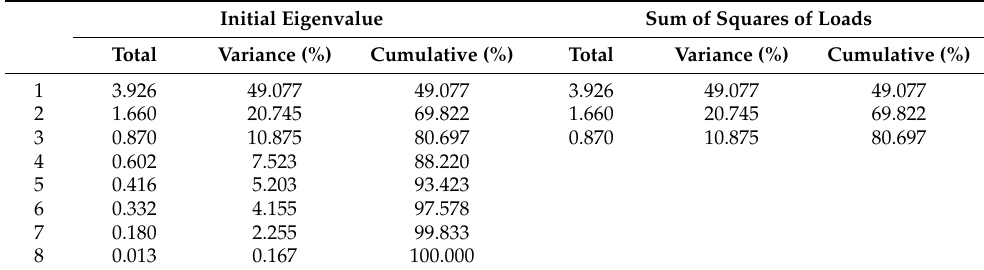
Table 7. Principal component